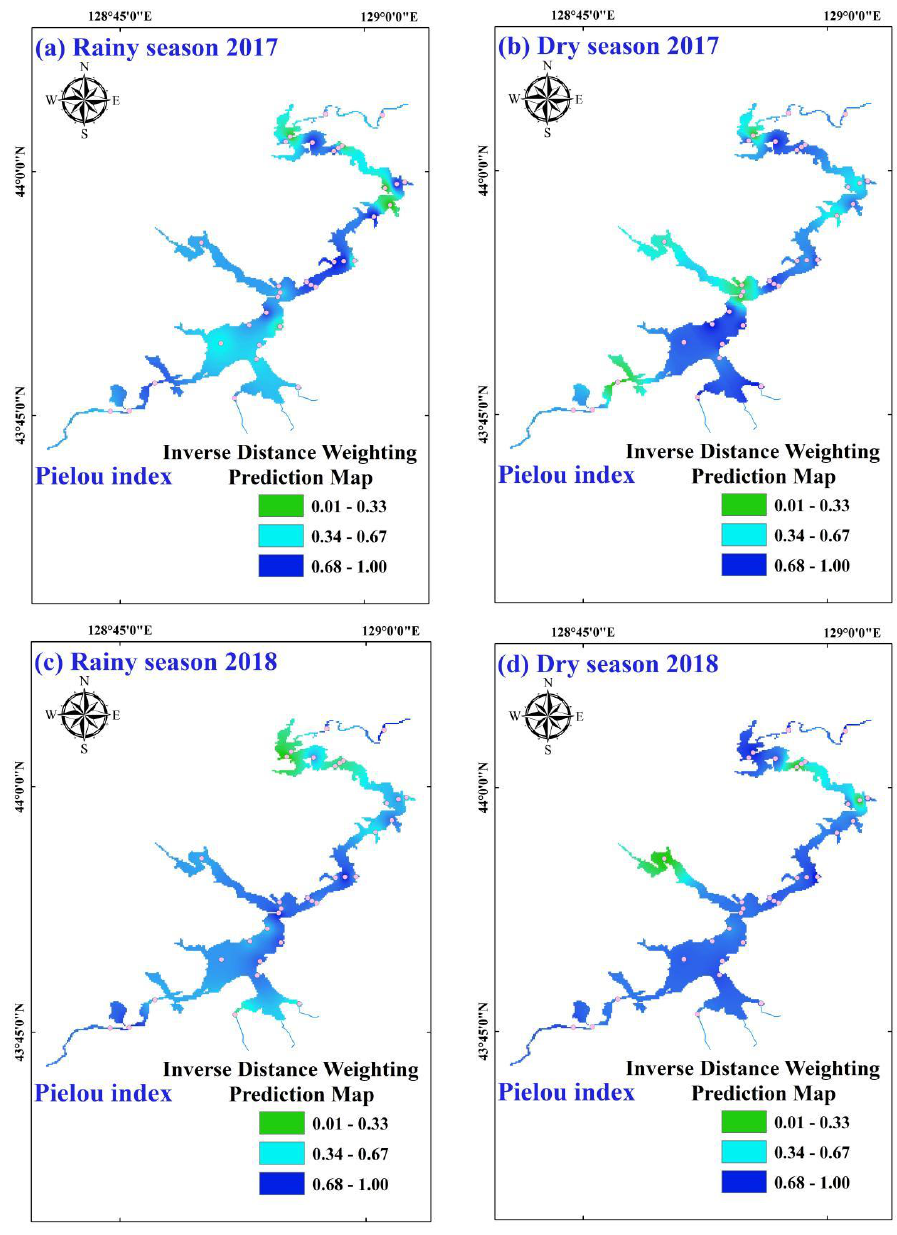
Figure 5. The spatial distribution of Pielou evenness index in study period. ( a ) Rainy season (August 2017); ( b ) dry season (October 2017); ( c ) rainy season (August 2018); ( d ) dry season (October 2018). The interpolation map was constructed by ArcGIS software using the Inverse Distance Weighting method. Table 4. The correlation coefficients found by CA of diversity indices and TLI in Jingpo Lake during the study